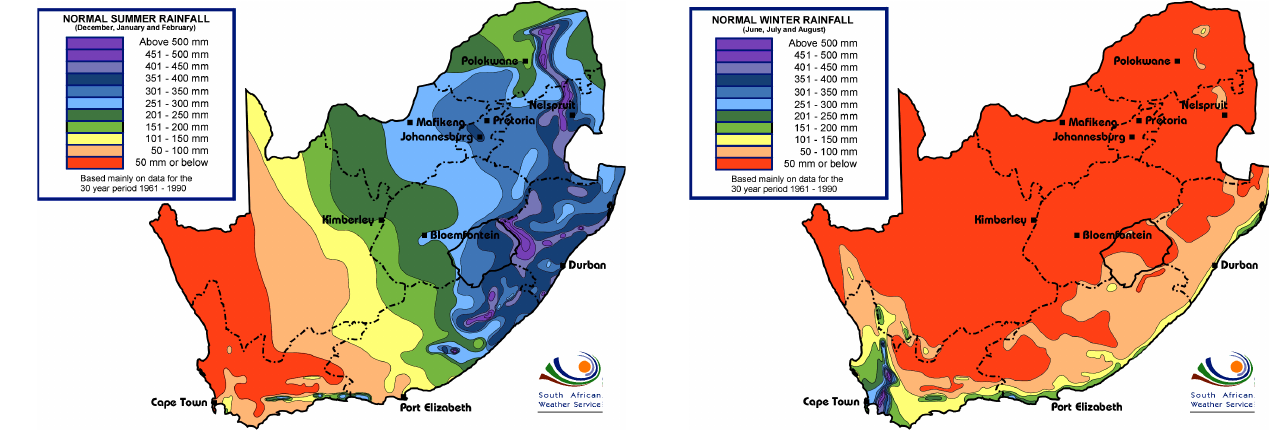
Fig. 1. Normal summer rainfall for South Africa (after Kruger, 2007).